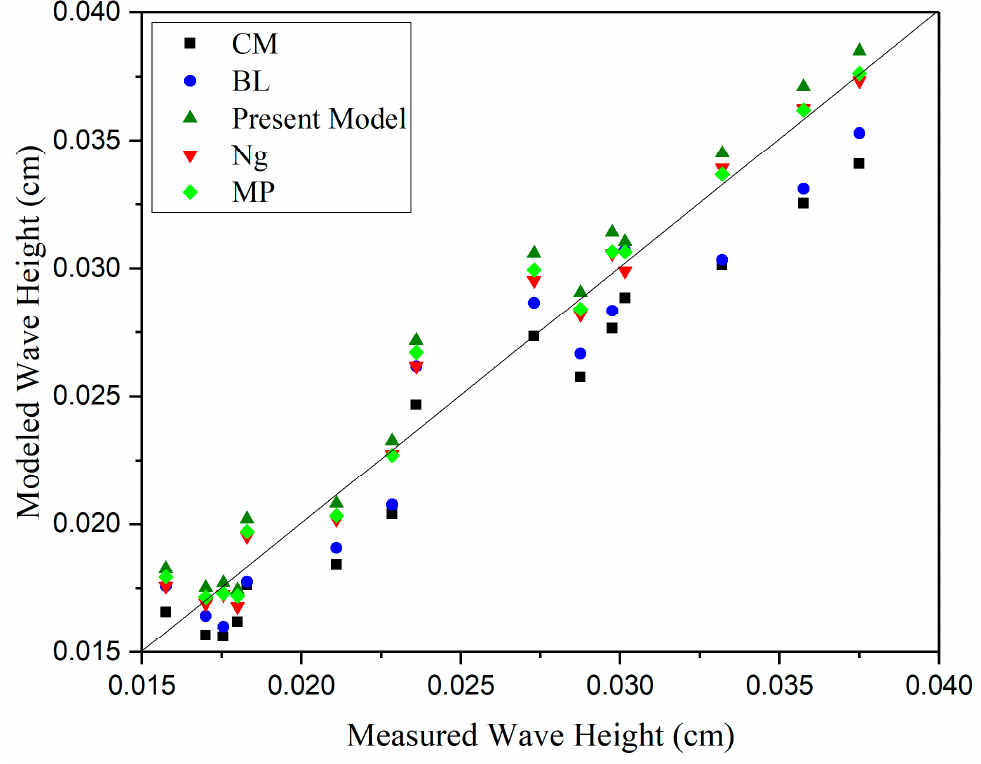
Figure 7. Comparison between experimental data and modeled values of attenuated wave height for no current case.